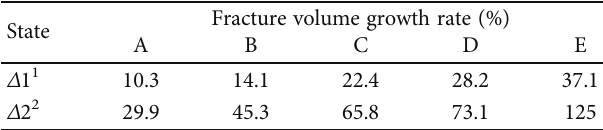
Table 3: The fracture volume growth rate of fi ve sandstone samples with di ff erent